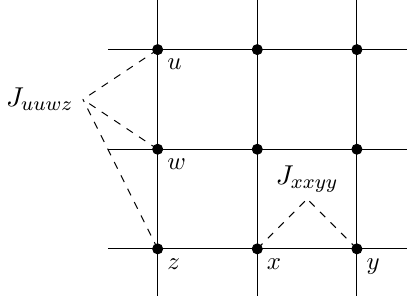
Figure 9. An example of two-dimensional square lattice model. The Hamiltonian could contain all kinds of random four-fermion terms, for example, J jklm;uuwz (cid:31) j;u (cid:31) k;u (cid:31) l;w (cid:31) m;z